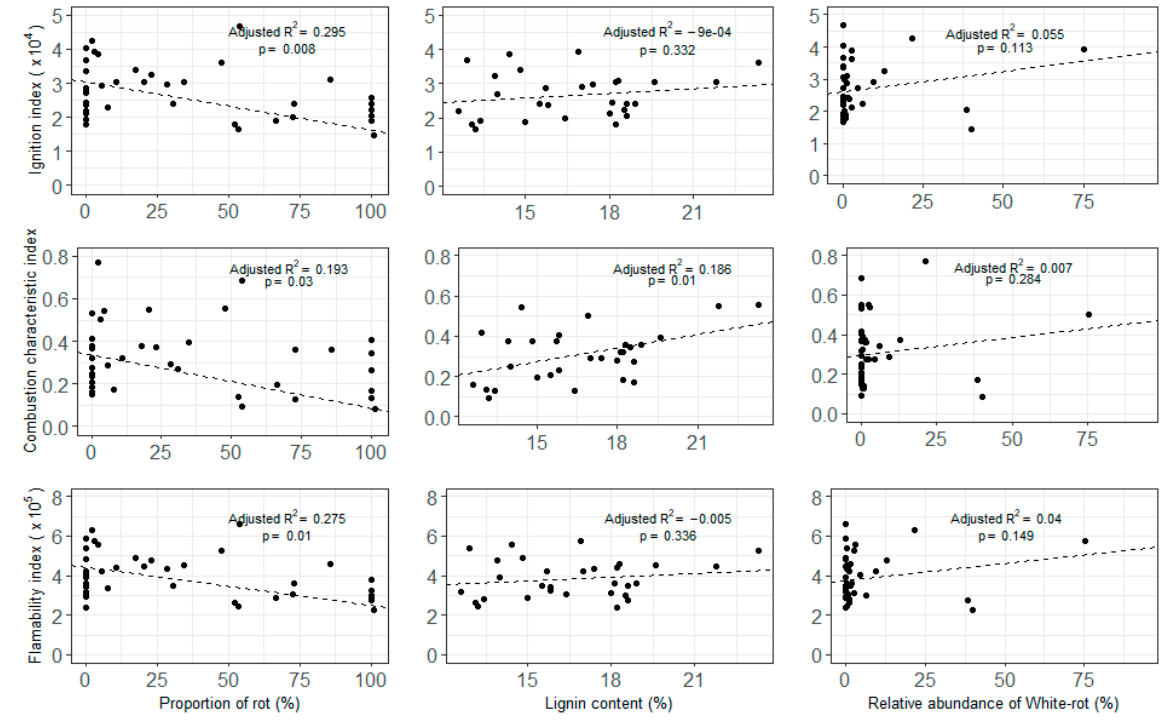
Figure 8. Variation of combustion characteristic parameters with proportion of rot, lignin content and relative abundance of white-rot fungi compared to all saprotrophs.